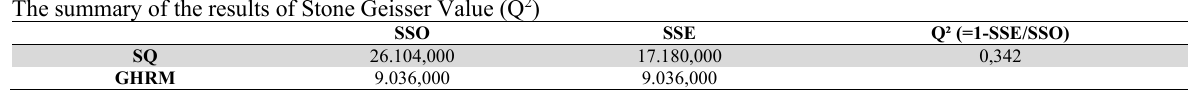
The results of path coefficients Original Sample (O) GHRM  SQ 0,256 0,257 0,037 6,862 0,000